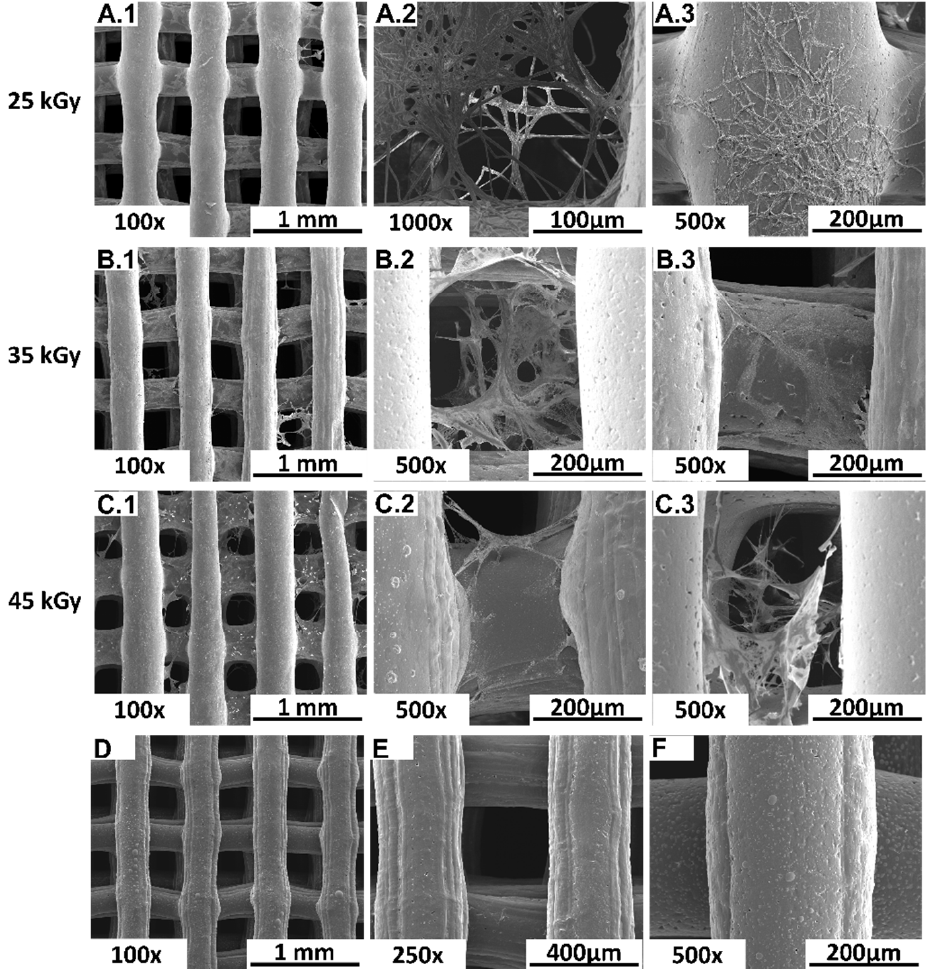
Figure 4. SEM images obtained from the 3D PCL devices seeded with hDPSCs. ( A1 – C3 ) represent seeded scaffolds sterilized with 25 kGy gamma radiation 35 kGy and 45 kGy, respectively. ( D – F ) represent the unseeded devices, sterilized with 25 kGy gamma radiation 35 kGy and 45 kGy, respectively. Left panel with 100× magnification and middle and right panel with 500× magnification.